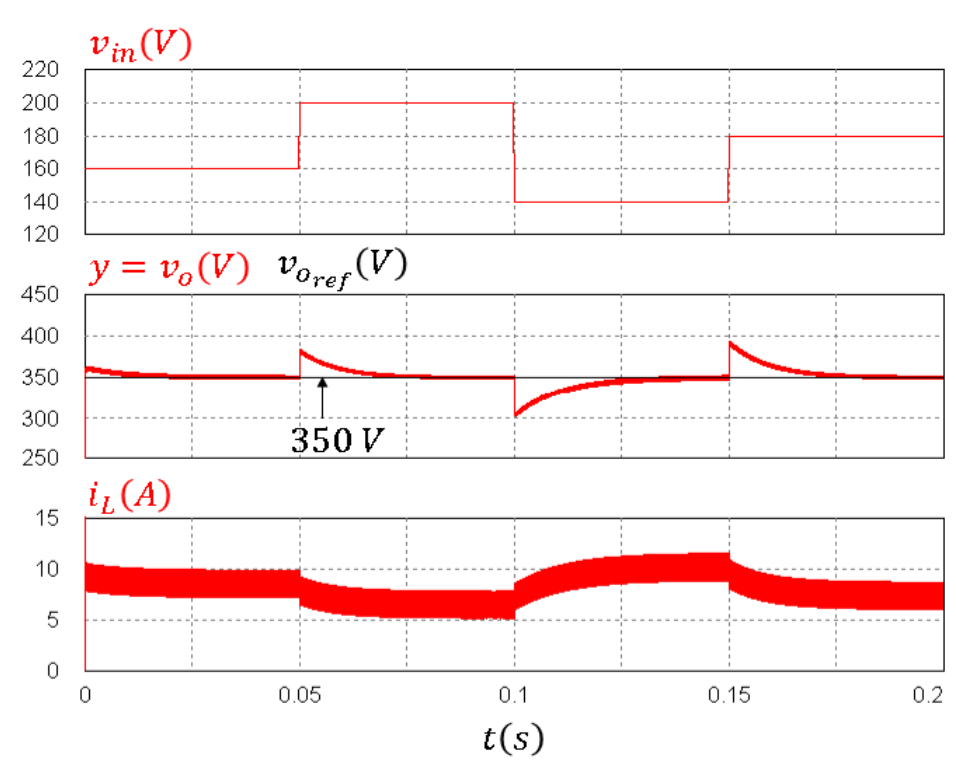
Figure 3. Response to increasing and decreasing variations of the input voltage.